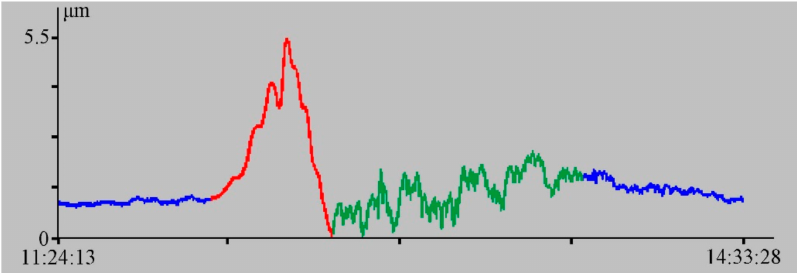
Figure 7. Fragment of “west–east” laser strainmeter record for 15 January 2022,